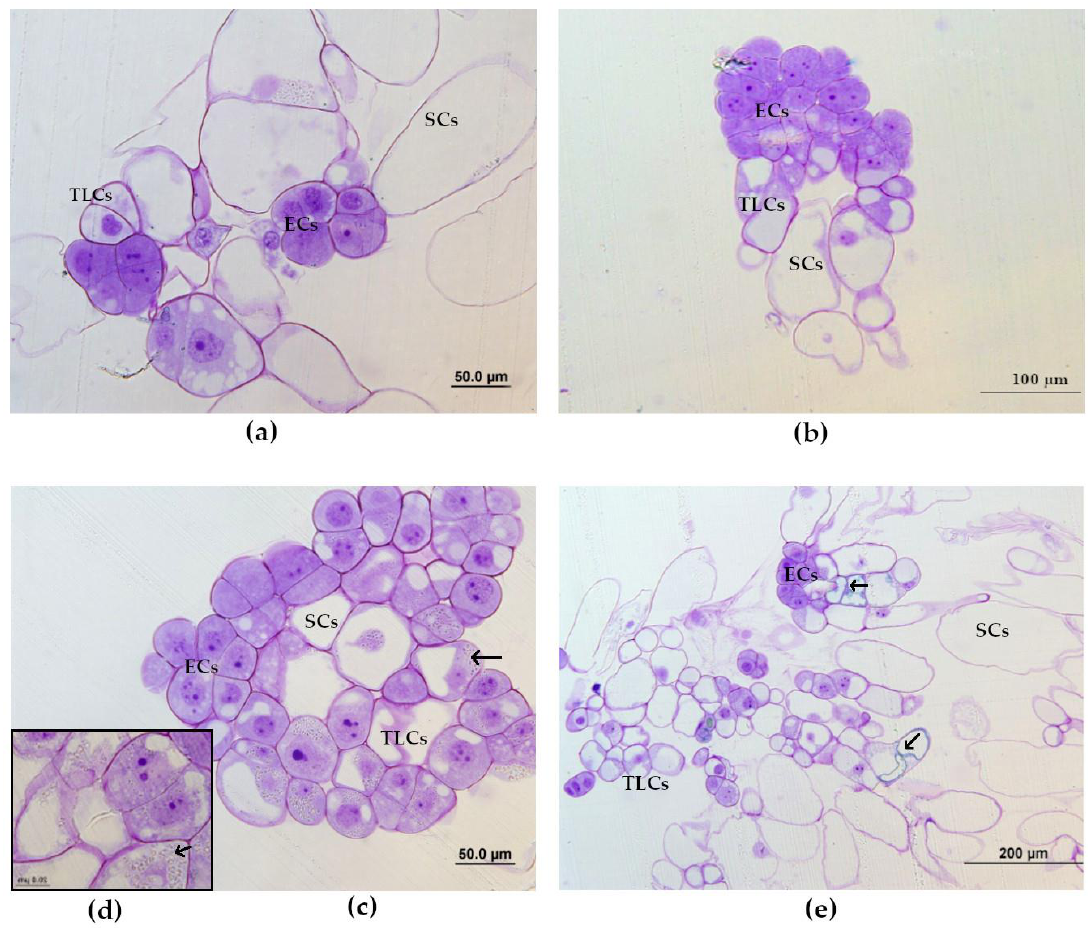
Figure 3. Light microscopy of embryogenic cultures from P. halepensis ( a ) proembryogenic masses (PEM) I with four embryogenic cells (ECs) linked to one suspensor cell (SCs), surrounded by some detached tube-like cells (TLCs); ( b ) PEM II, showing a defined polarization with one pole formed by several ECs, linked to TLCs. Scattered vacuolated cells (SCs) can also be observed; ( c ) cluster of embryogenic cells without clear polarization, with the presence of starch grains (arrow); ( d ) detail of starch grains (arrow) that could be detected on samples from all induction treatments; ( e ) PEM clusters induced at 60 ° C for 5 min, without defined polarization, containing phenolic compounds (arrow).